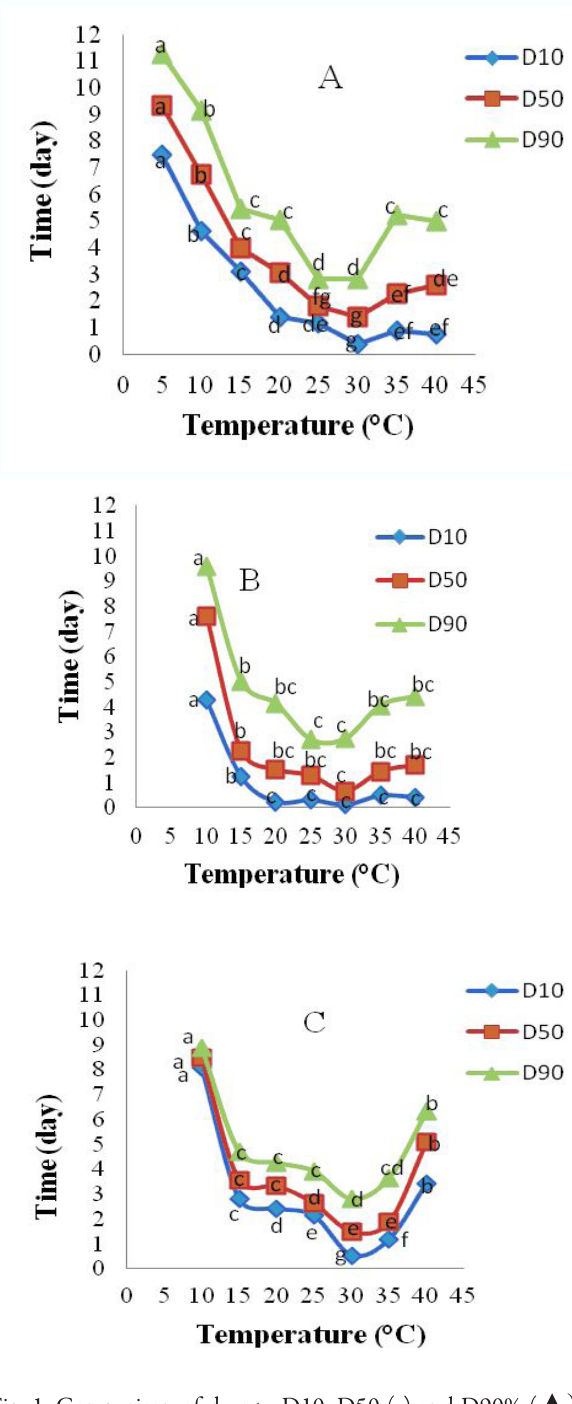
Fig. 1. Comparison of days to D10, D50 (■) and D90% ( ▲) 0f germination for (A) hyssop, (B) sweet basil and (C) oregano Significant at α= 0.05